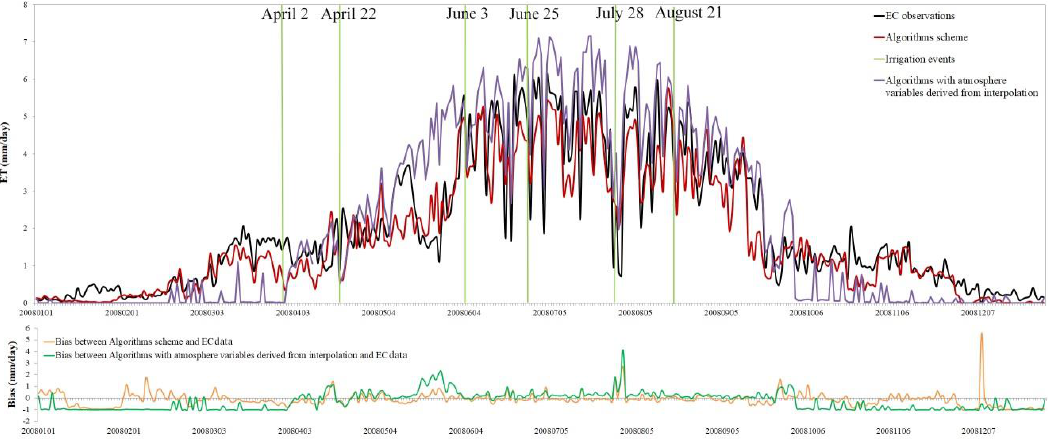
Figure 5. Daily ET in 2008 at the Yingke station comparing EC observations (black line) with estimations using atmospheric variables derived from satellite data (red line) and from interpolation of meteorological measurements (purple line), and dates of irrigation events (vertical line).